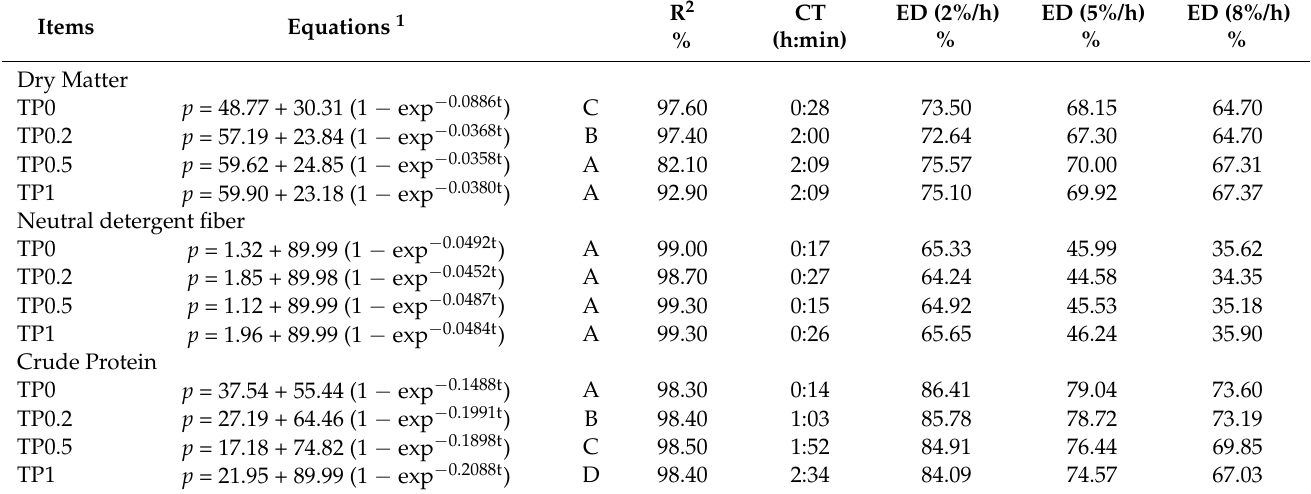
Table 8. Equations of ruminal degradation, colonization time (CT), effective degradability (ED) of dry matter (DM), neutral detergent fiber (NDF) and crude protein (CP) of wheat bran as a function